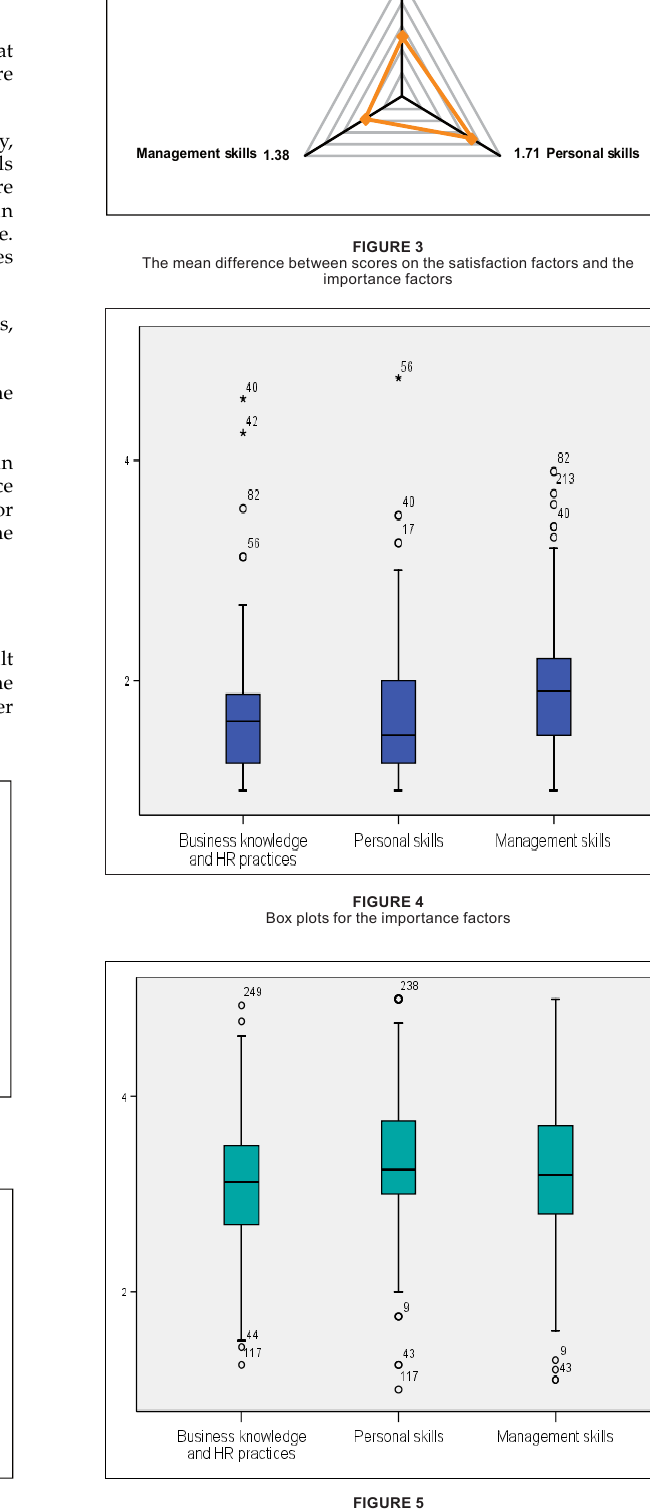
FiguRE 5 Box plots for the satisfaction